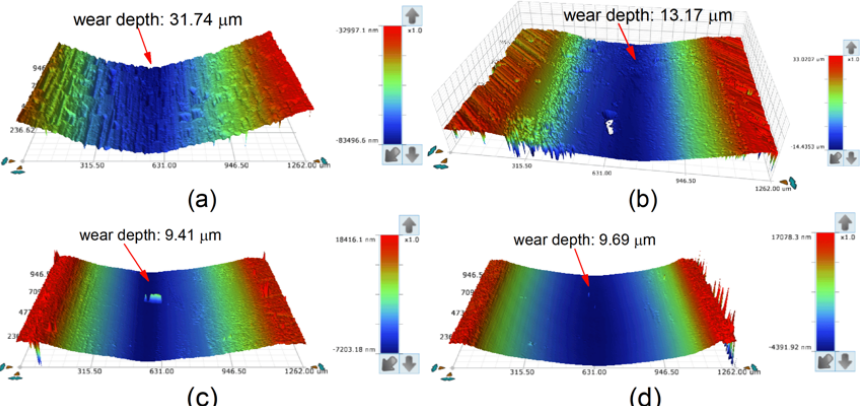
Figure 16. Three-dimensional topography of the wear tracks: ( a ) substrate; ( b ) laser power of 2200 W; ( c ) laser power of 2500 W; ( d ) laser power of 2800 W.